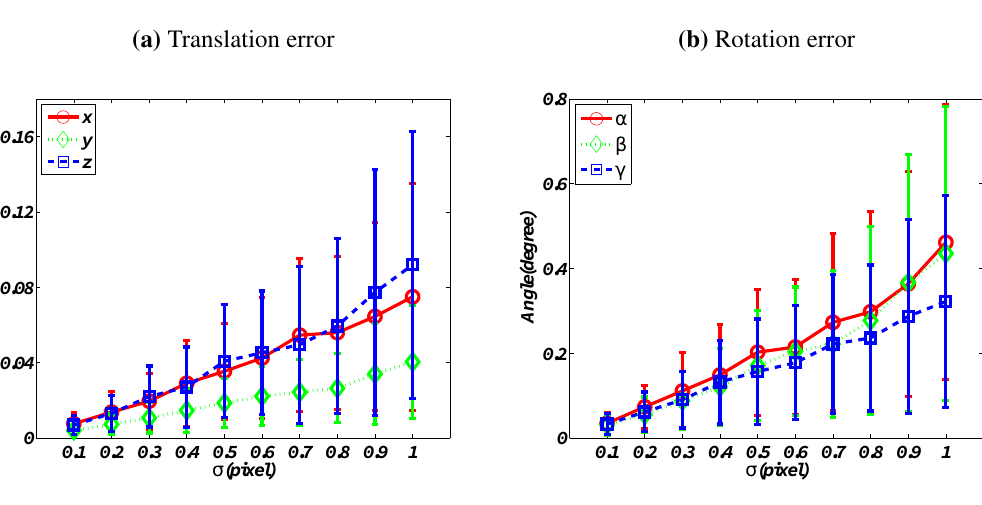
Figure 4. Errors vs. the noise level on image points. ( a ) presents the translation’s absolute errors in X , Y , and Z directions. ( b ) is the displaced Euler angle [ (cid:11); (cid:12); (cid:13) ] T